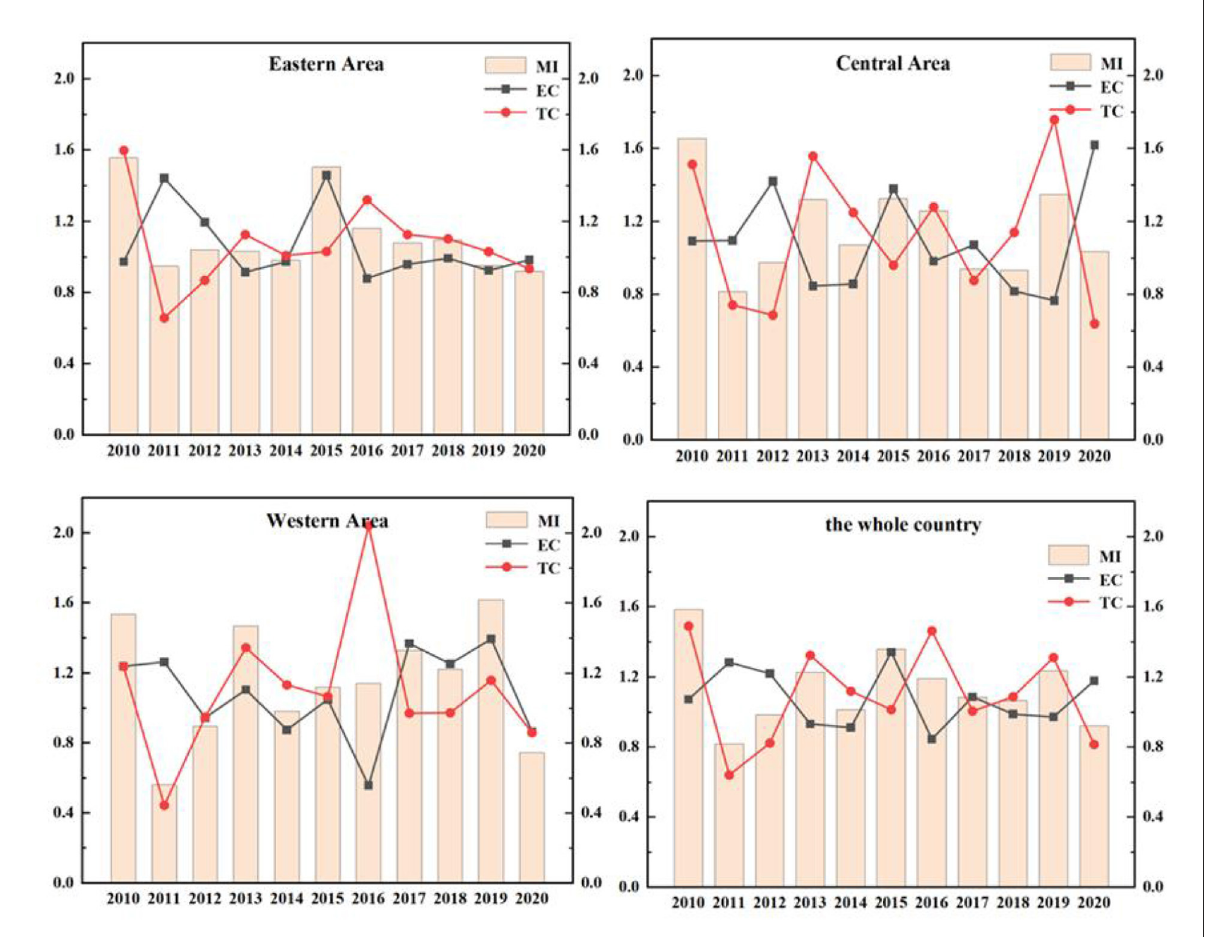
FIGURE6 EETS and its decomposition index in different regions from 2010 to